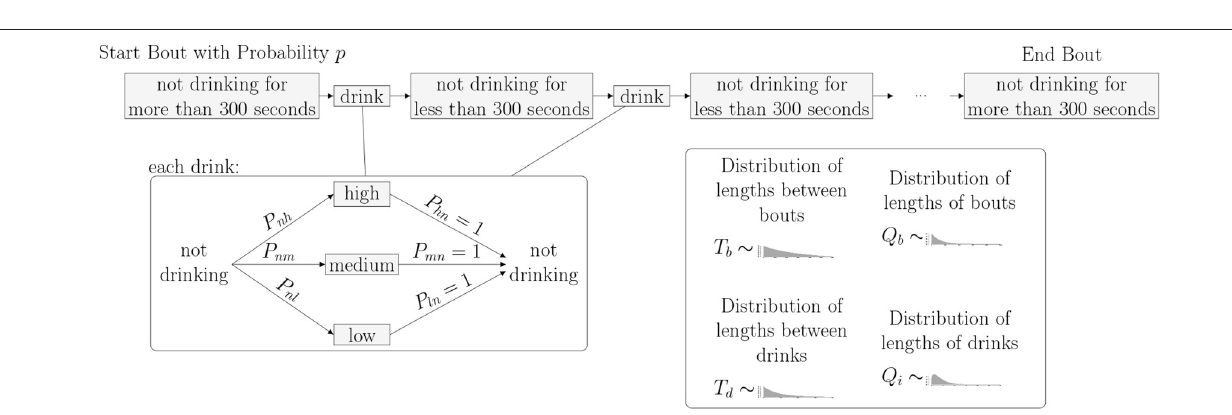
Frontiers in Applied Mathematics and Statistics |